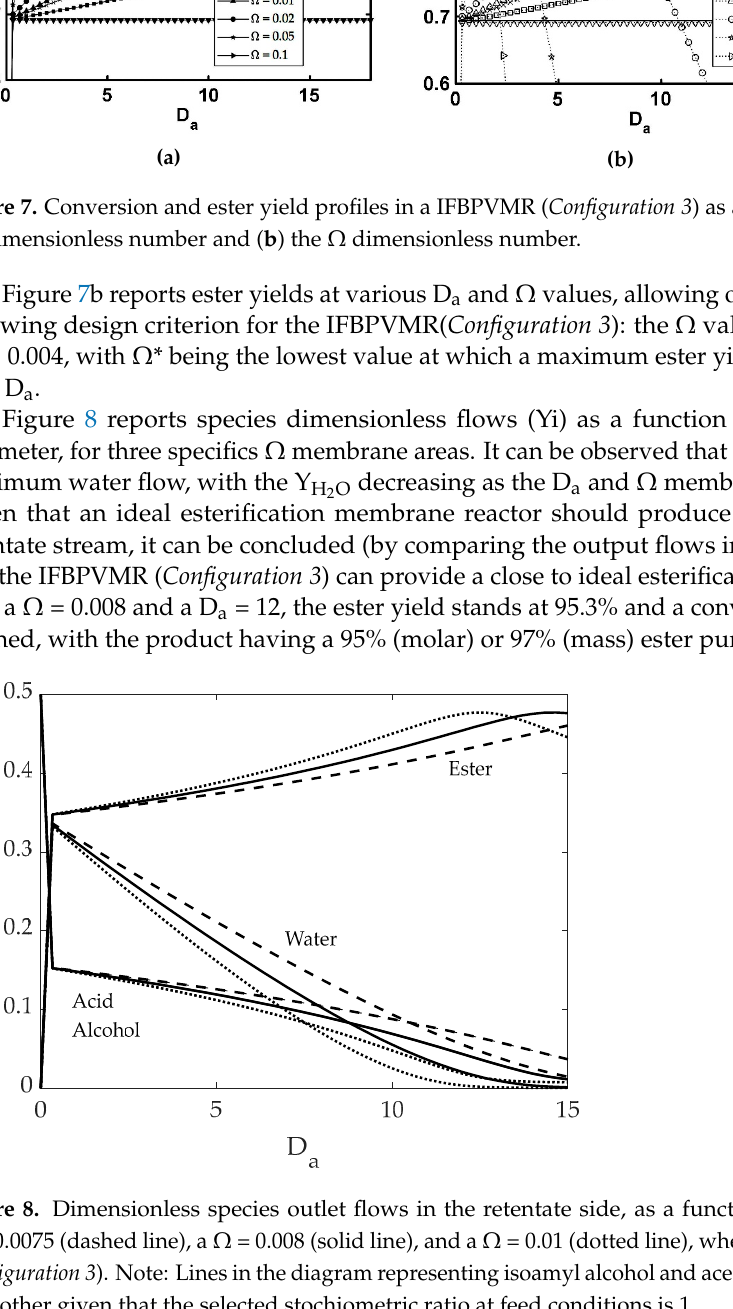
(b) Figure 9. Isoamyl alcohol conversion ( a ) and ester yield ( b ) profiles in a ISPVMR ( Configuration 4 ), as a Function of D a and Ω . Figure 10 also displays Yi dimensionless flows with similar trends, for the ISPVMR ( Configuration 4 ) and the IFBPVMR ( Configuration 3 ). One can notice, however, that the ester recovered in the retentate membrane side of the ISPVMR has a lower purity than the one obtained in the IFBPVMR, at similar operating conditions.